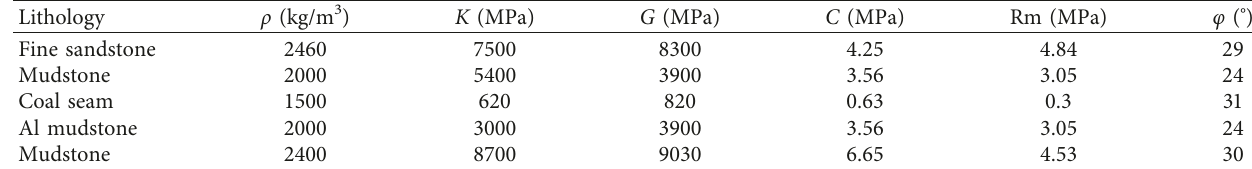
Table 1: Lithologies and petrophysical parameters of the roof and floor.